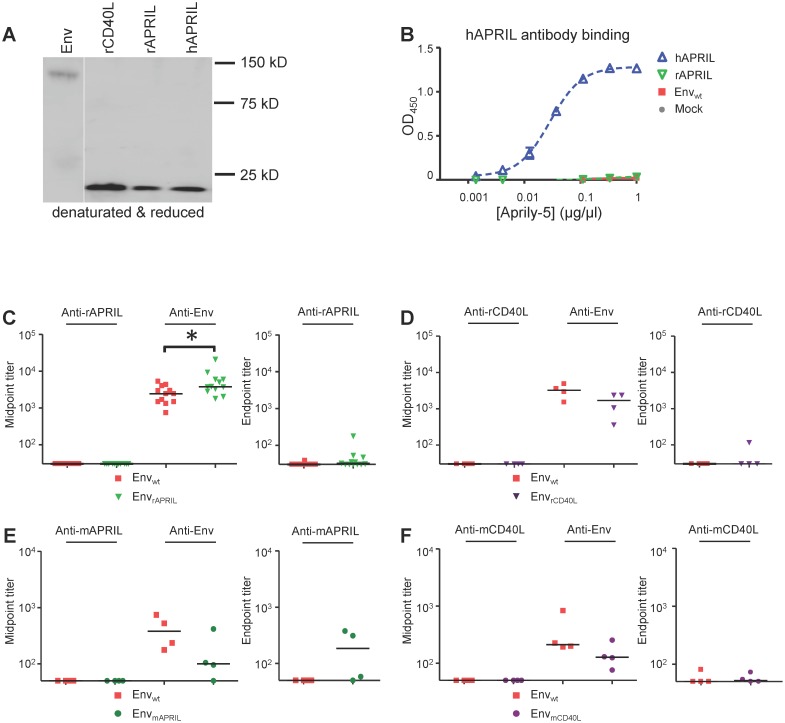
EnvAPRIL and EnvCD40L induce minimal anti-APRIL and anti-CD40L responses in mice and rabbits.(A) Reducing SDS-PAGE analysis of Envwt, hAPRIL, rAPRIL and rCD40L proteins followed by western blot using an MAb against the His-tag. The migration of marker proteins is indicated. Envwtmigrated at the expected apparent m.wt. of 140 kD, while the migration pattern of hAPRIL, rAPRIL and rCD40L was as expected based on their size of ∼17 kD. (B) Detection of hAPRIL by ELISA using Ab Aprily-5. (C) Midpoint titers of anti-rAPRIL and anti-gp140 Abs (left panel) and endpoint titers of anti-rAPRIL Abs (right panel) of week 10 sera from rabbits immunized with Envwt or EnvrAPRIL (n = 12). (D) Midpoint titers of anti-rCD40L and anti-gp140 Abs (left panel) and endpoint titers of anti-rCD40L Abs (right panel) of week 12 sera from rabbits immunized with Envwt or EnvrCD40L (n = 4). These 8 rabbits are described in reference [13]. (E, F) Midpoint titers of anti-mAPRIL (E), anti-mCD40L (F) and anti-gp140 Abs (left panels) and endpoint titers of anti-mAPRIL (E), anti-mCD40L Abs (F) (right panels) of week 8 sera from mice immunized with Envwt, EnvmAPRIL, EnvmCD40L (n = 4). The mice were from the study described in reference [18]. All sera were tested in duplicate with the mean values shown.